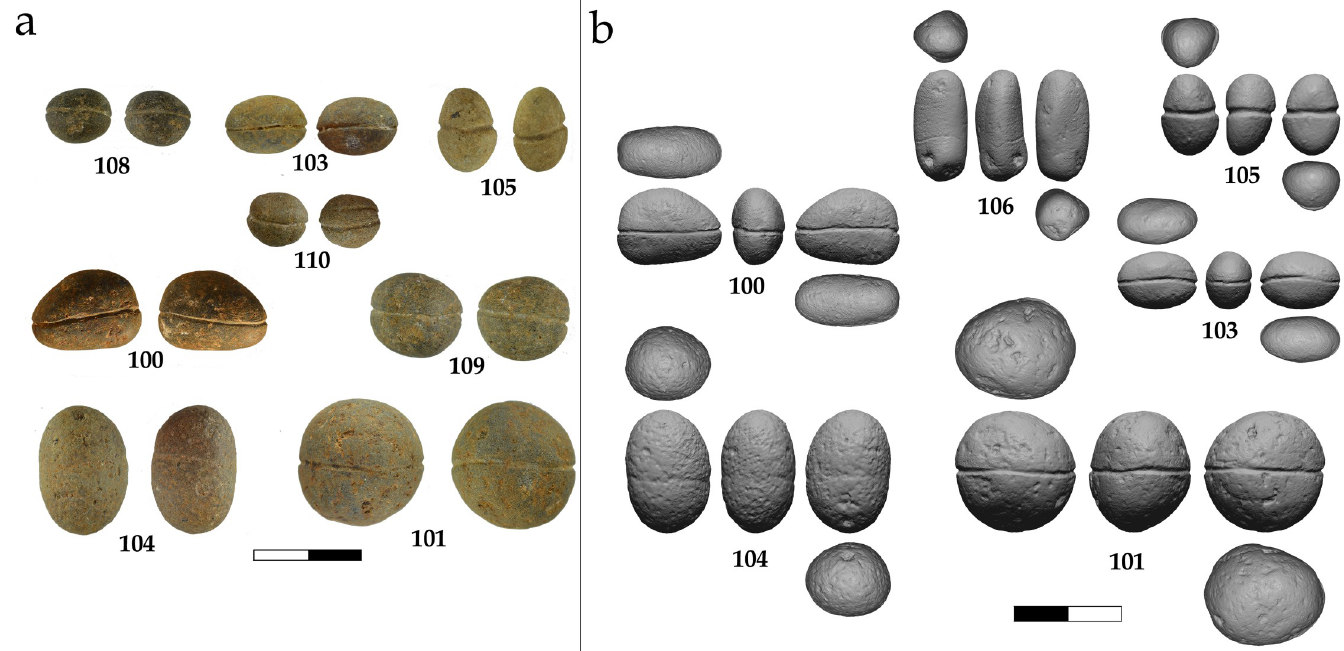
Fig 11. Grooved pebbles from JRD. a) Selected grooved pebbles; b) 3D models of the six analyzed pebbles. Numbers are according to site data catalog.